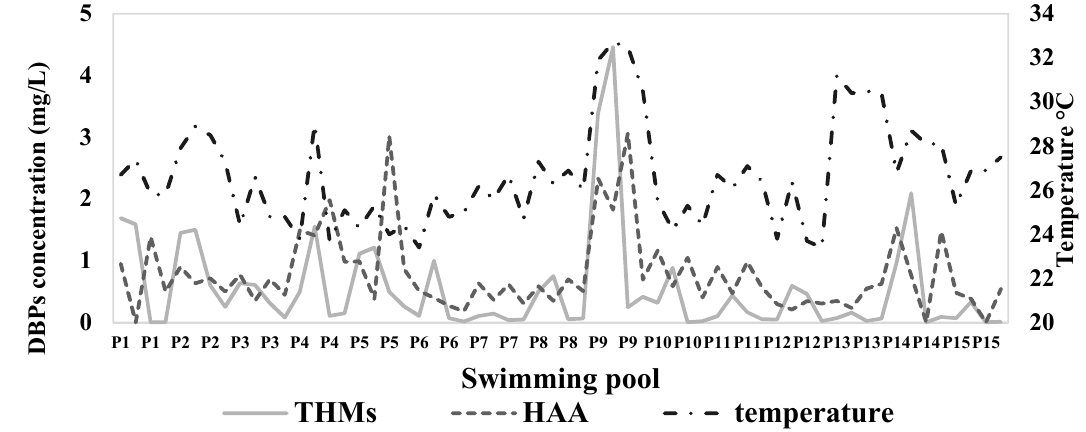
Figure 4. Water temperature during sampling for the measurement of THMs and HAAs in the public pools selected for the study.